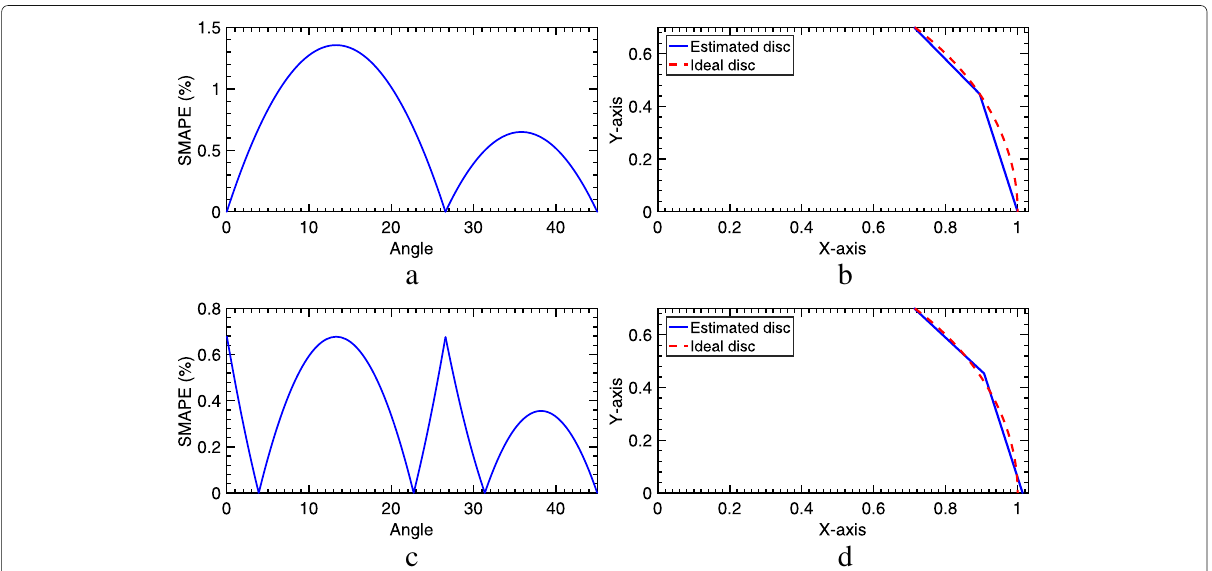
Fig. 5 Symmetric mean absolute percentage error or SMAPE (left column) and edge geometry (right column) generated by a 5 × 5 chamfer kernel. a Euclidean weights, a = 1, b = c = 2.2059. d Our weights, a = 0.9865, b =